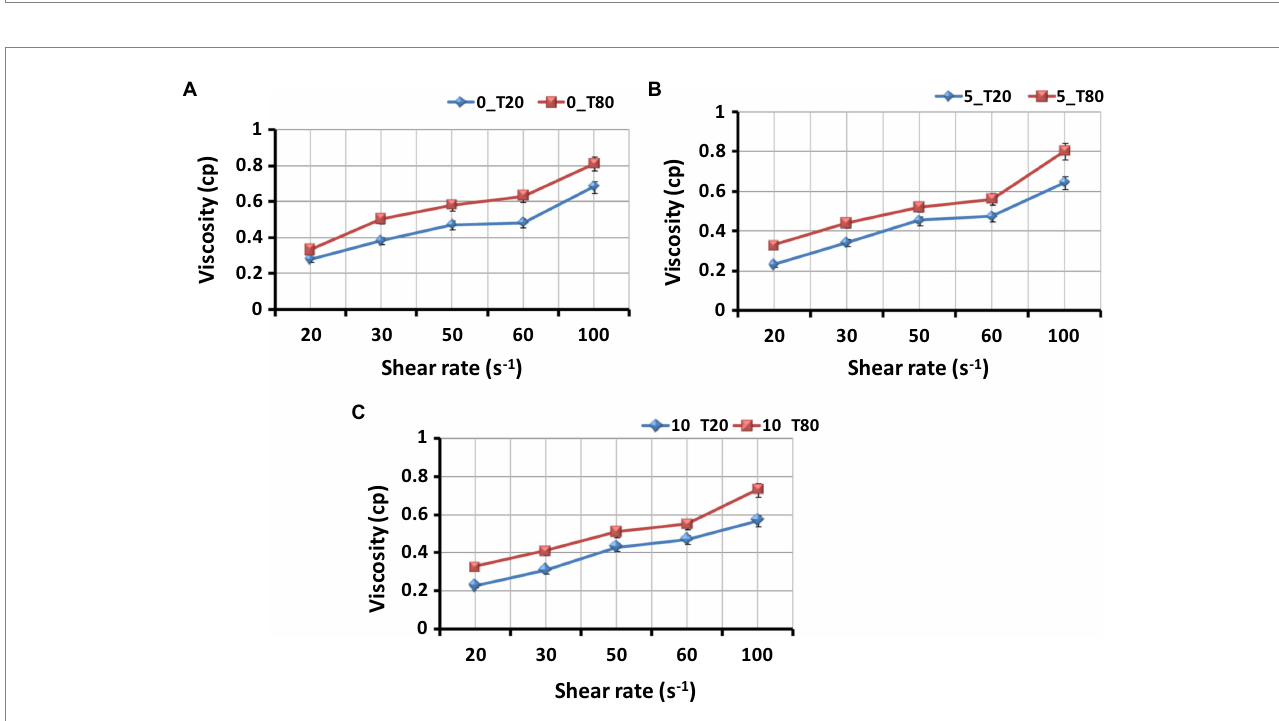
FIGURE 5 Effect of type of surfactant on the viscosity of the Nigella sativa oil nanoemulsions. (A) 0_T20 and 0_T80; (B) 5_T20 and 5_T80; (C) 10_T20 and 10_T80; Bars represent standard error of means (SEM).